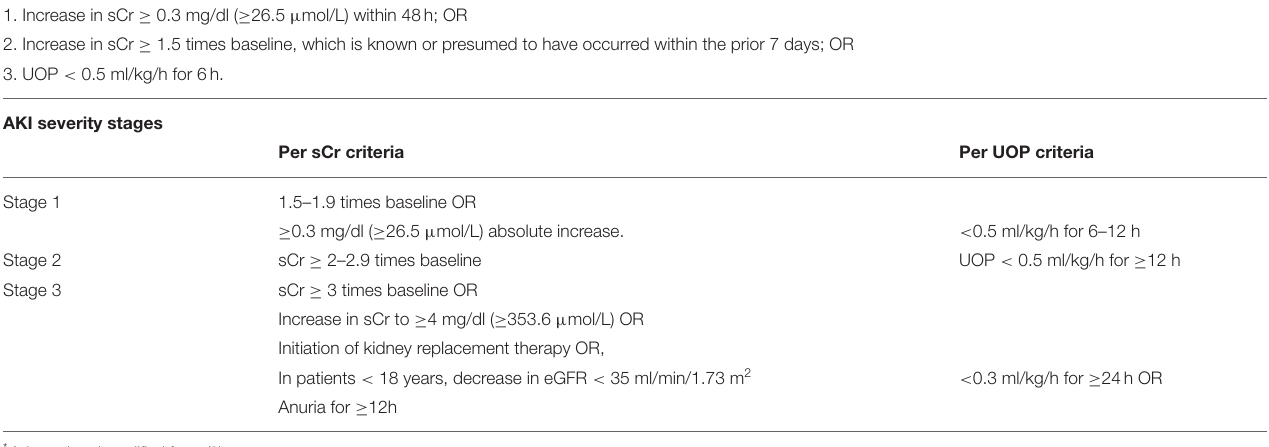
TABLE 1 | The kidney disease improving global outcomes (KDIGO) definition and classification of acute kidney injury (AKI) * .